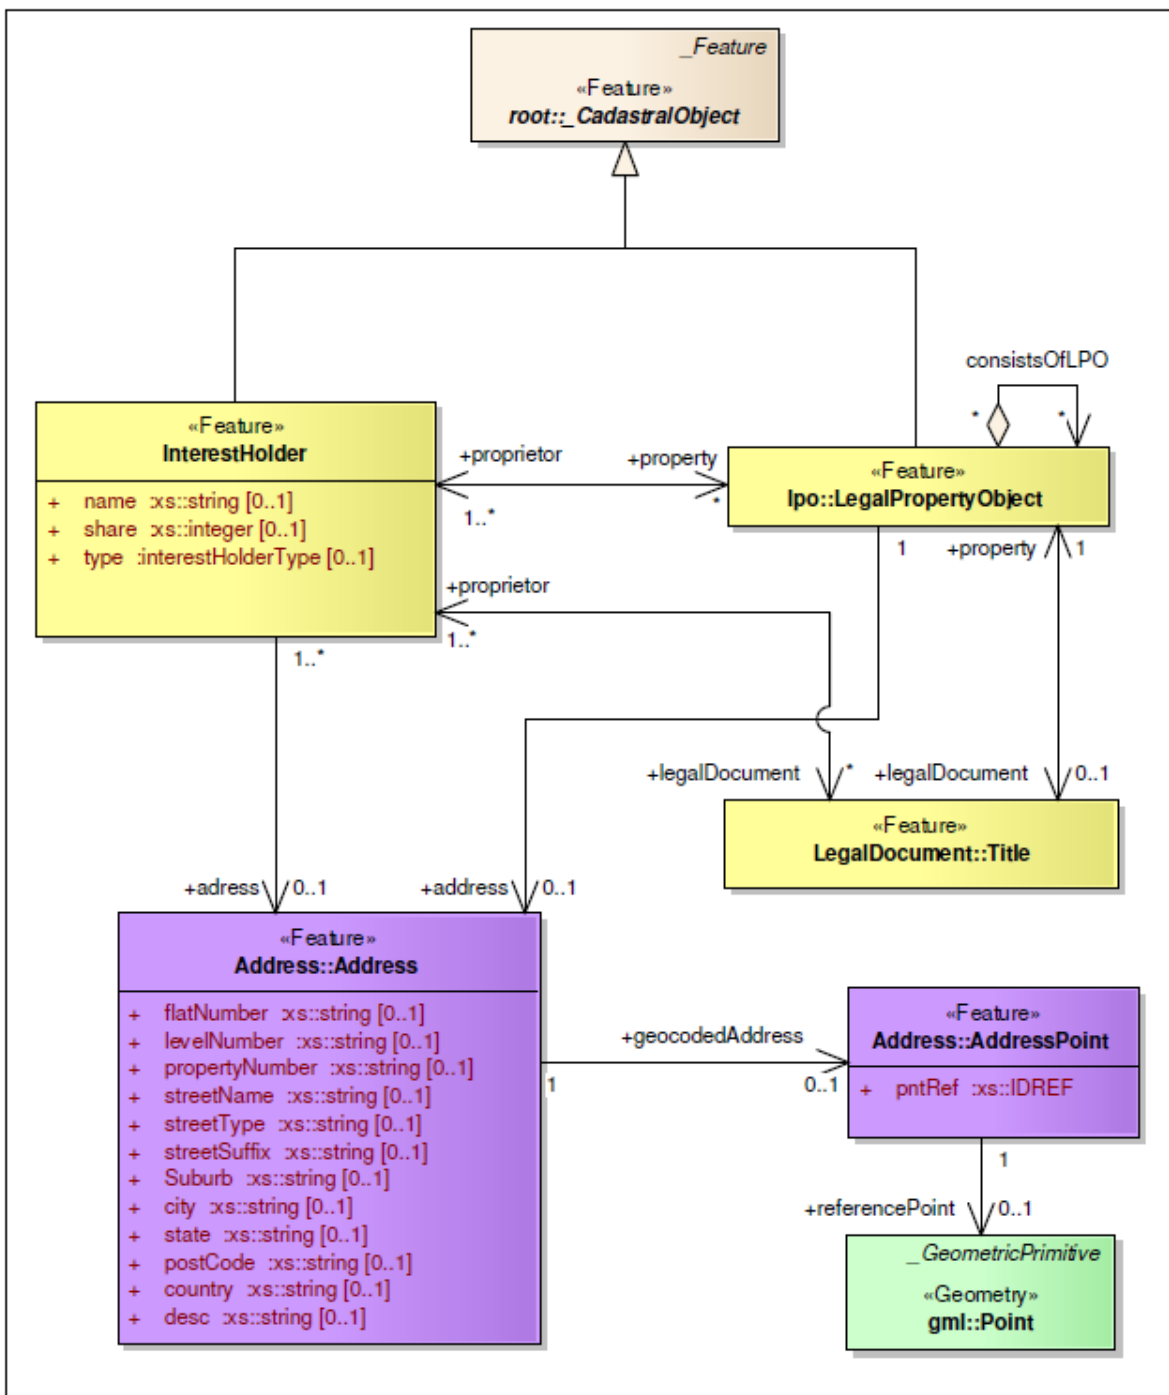
Figure 14. The UML diagram of 3DCDM InterestHolder